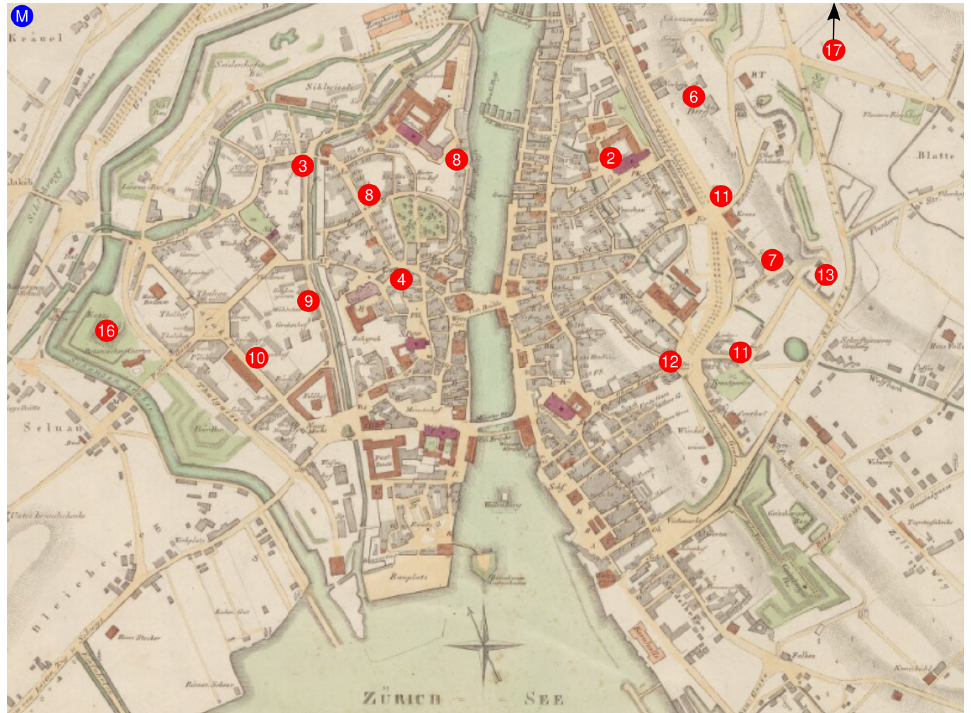
Figure 4. Measurement locations drawn on a historical map of Zurich (Heinrich Keller, 1838). The numbers refer to Table 2, and the “M” indicates the position of the MeteoSwiss station of Zurich–Zeughaushof. Note that the position of the observatory (17) lies outside the map. Map source: Staatsarchiv des Kantons